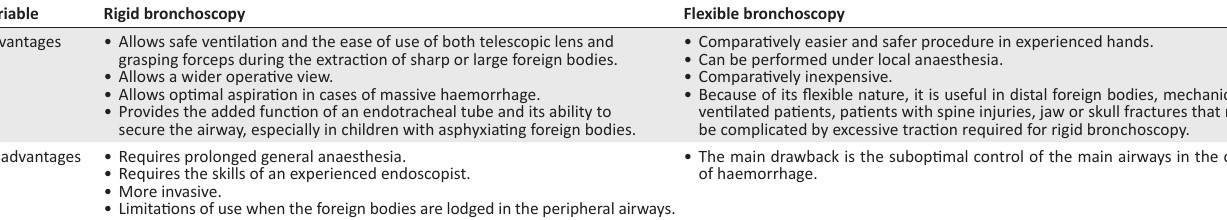
FIGURE 17: Sagittal reformatted magnetic resonance imaging brain image (a) shows the first documented case of nasopharyngeal lodgement of an aspirated rambutan fruit (b) in a 6-month-old child who was brought to the emergency room with asphyxiation and cardiac arrest. Magnetic resonance imaging brain was performed to evaluate for encephalopathy-related changes when the exotic fruit was identified in the nasopharynx. TABLE 2: Rigid bronchoscopy versus flexible bronchoscopy, the advantages and disadvantages. Variable Rigid